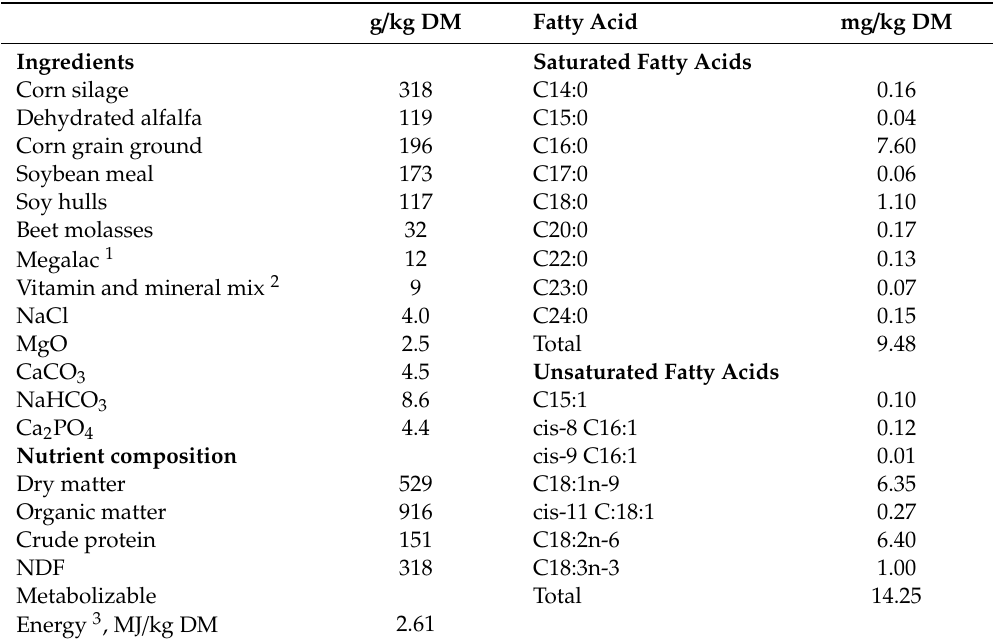
Table 1. Ingredients and chemical composition of the total mixed